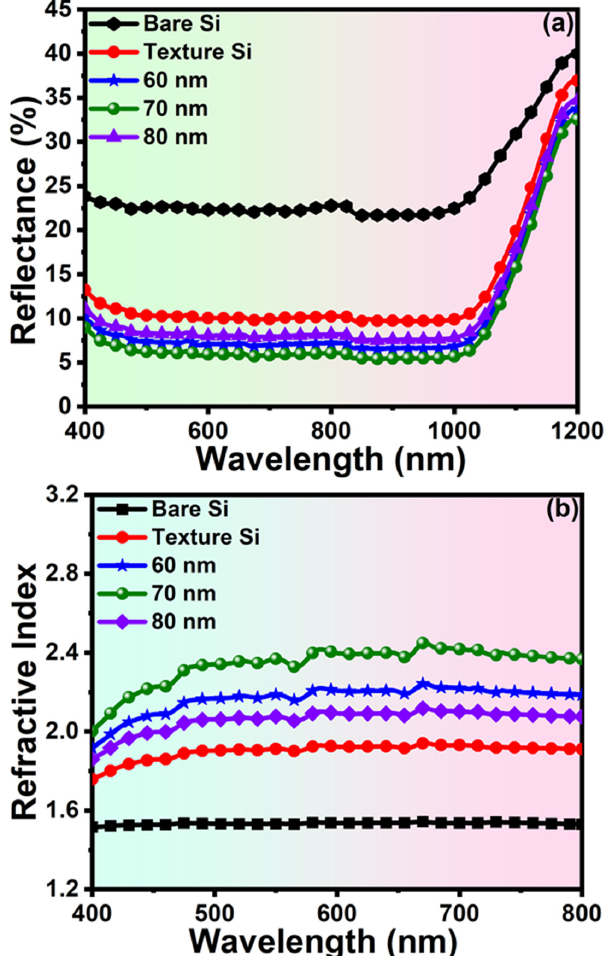
Figure 5. UV-DRS spectra in ( a ) reflectance mode and their corresponding ( b ) refractive index of HfO 2 ARC layer-based c-Si solar cell.